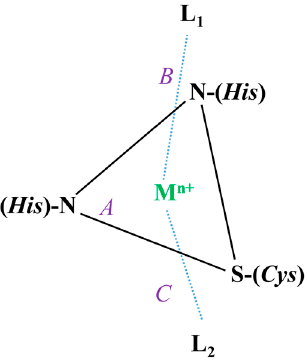
Figure 1. Geometrical composition of the metal-binding center in T1 copper proteins. A: the trigonal planar composition of the three amino acid residues (two histidines and one cysteine) characteristic for all T1Cu proteins; B axial ligand L 1 (methionine in Class 1, and non-methionine in Class 2) distinguishing a distorted tetrahedron; C axial ligand L 2 (absent in Classes 1 and 2, peptide-residue from glycine in Class 3, in combination with methionine as L 1 ), which gives rise to a distorted trigonal bipyramidal geometry.